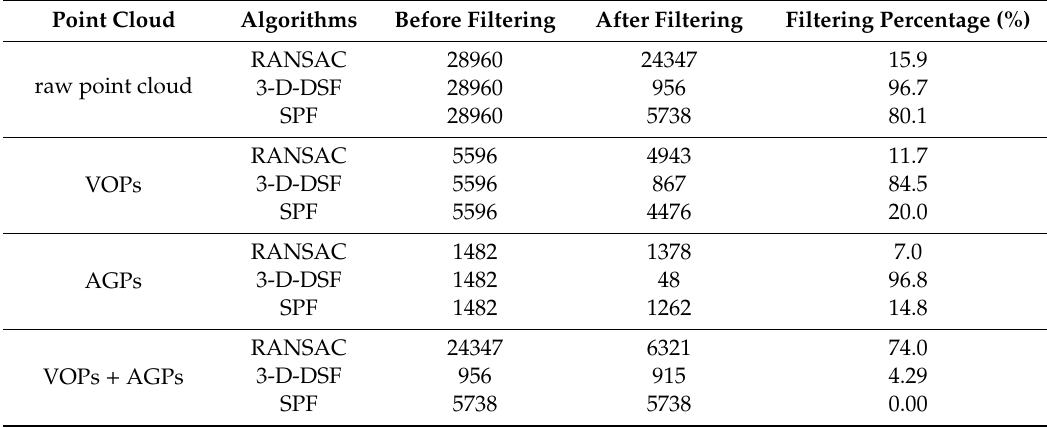
Table 2. The background point filtering results by di ff erent